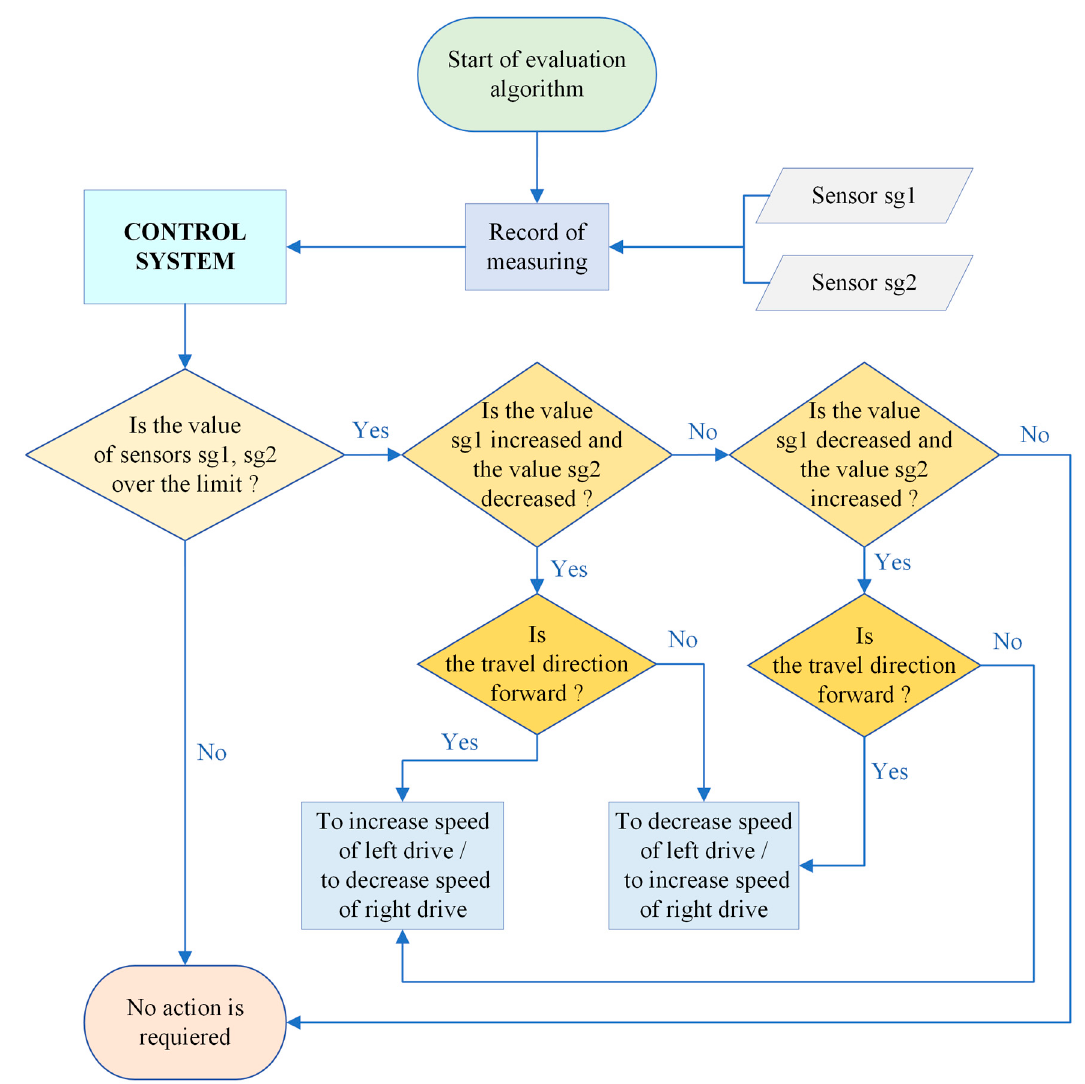
Figure 14. Evaluation algorithm determined for elimination of the crane